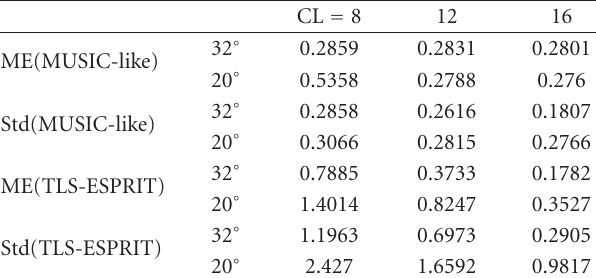
Table 1: Results with increase of